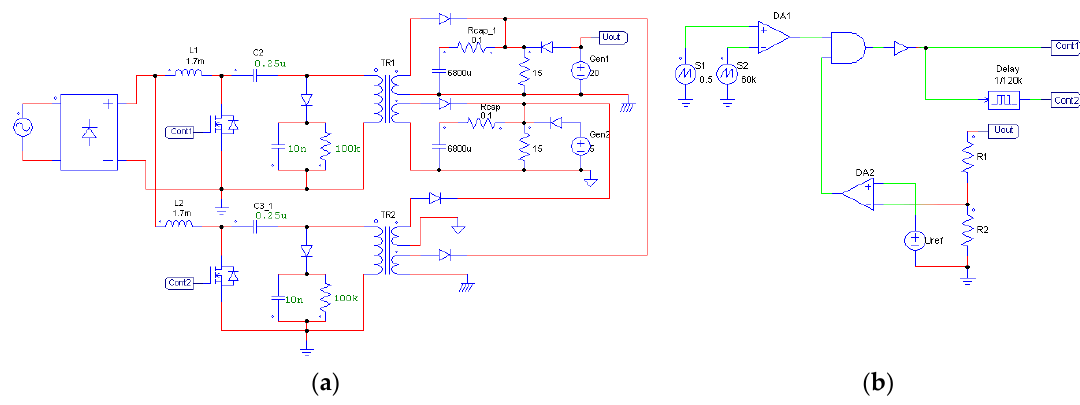
Figure 14. PSIM model: ( a ) SEPIC power circuit; ( b ) corresponding control system.